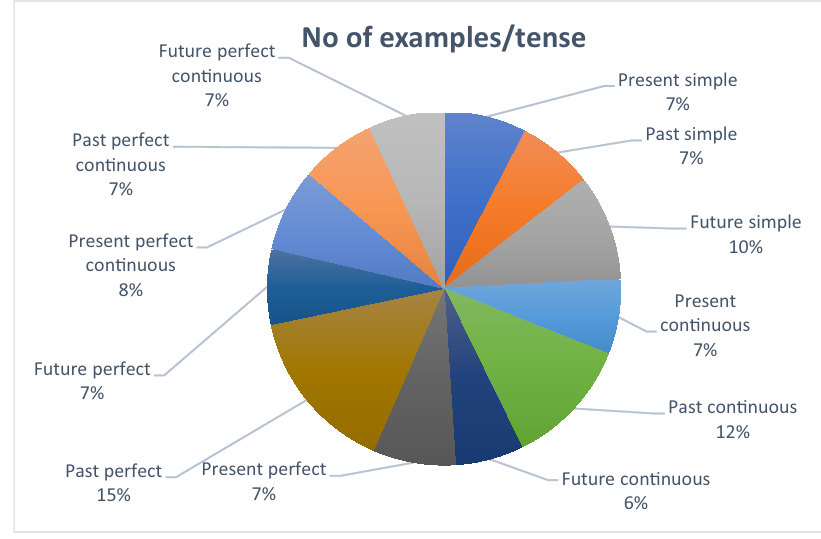
Figure 1: Distribution of test suite sentences over